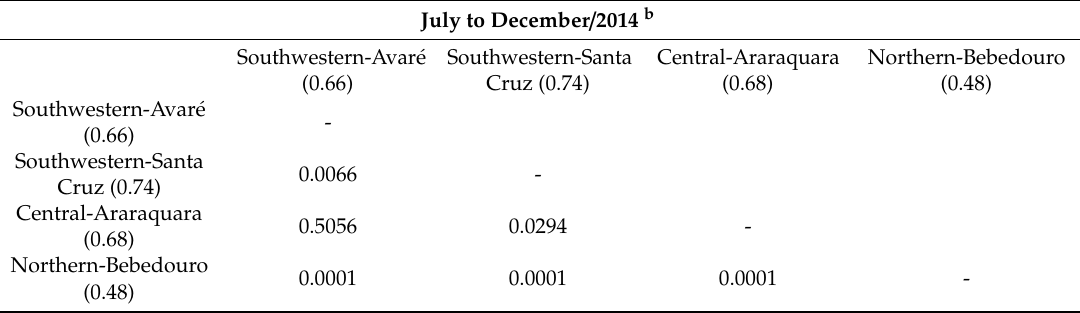
Table 4. Comparison of the proportion of psyllids carrying Candidatus Liberibacter asiaticus among southwestern, central, and northern regions of S ã o Paulo state, Brazil and the observed p value for each combination.